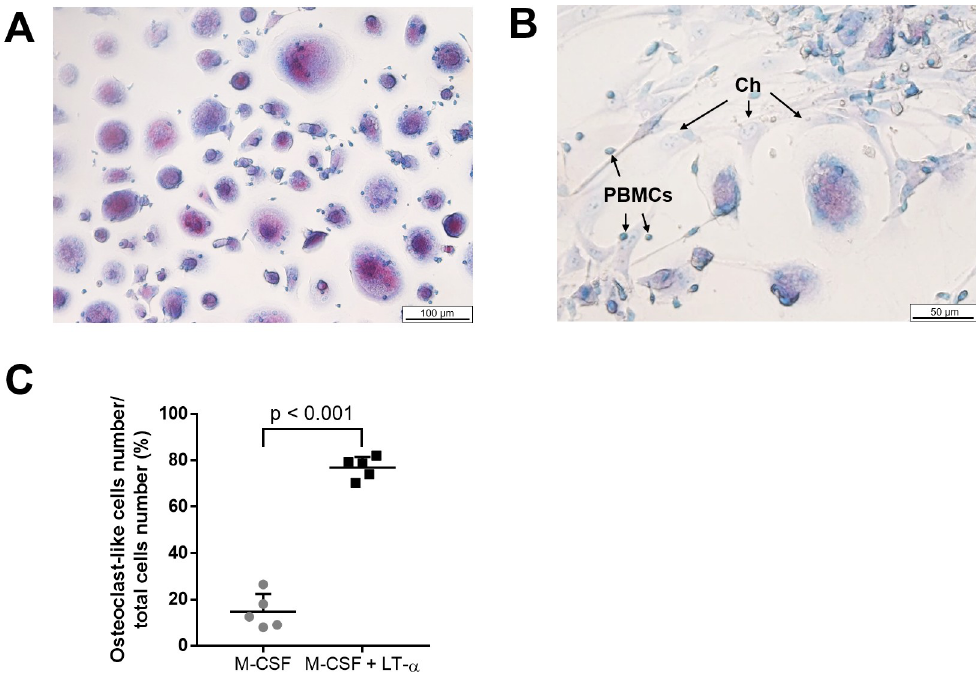
Fig 7. RANKL synthesized by human chondrocytes promoted the differentiation of osteoclast–like cells. (A) RANKL produced by chondrocytes stimulated with LT– α 1 ng/ml induced the differentiation of monocytes into osteoclast–like cells. (B) Although TRAP–positive multinucleated cells were observed in the absence of LT– α , their TRAP staining was weak. The direct contact between chondrocytes and osteoclast–like cells or PBMCs was observed. (C) The number of TRAP–positive multinucleated cell in presence of LT– α was 5.2–hold larger than that in the absence of LT– α (n = 5 per experimental group). Ch, chondrocyte; PBMCs, Peripheral blood mononuclear cells.